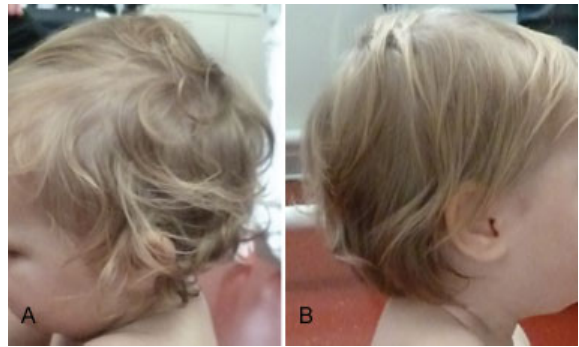
Fig. 4 Photograph taken at 16 months. ( A ) Straight hair on the right side of her head which is affected by Horner ’ s syndrome. ( B ) The original hair texture of the infant is retained on the left side of the head which is not affected by Horner ’ s